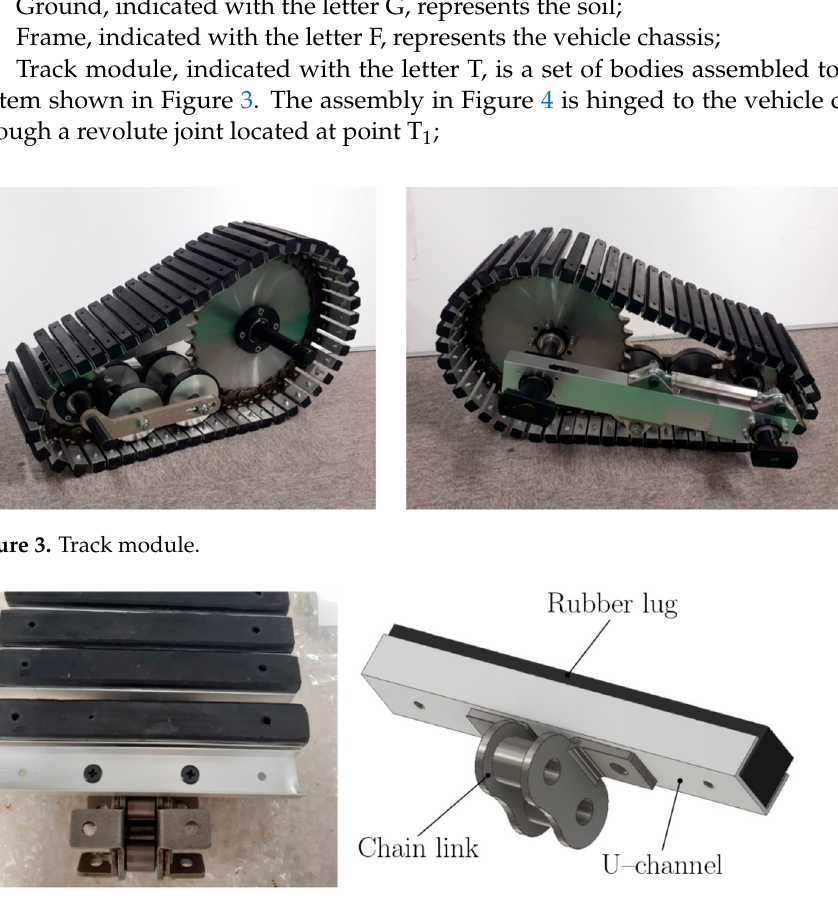
Figure 4. Detail the track belt ( left ) and the track link ( right ) components. Shock absorber, indicated with the letter S (blue line). According to one of the